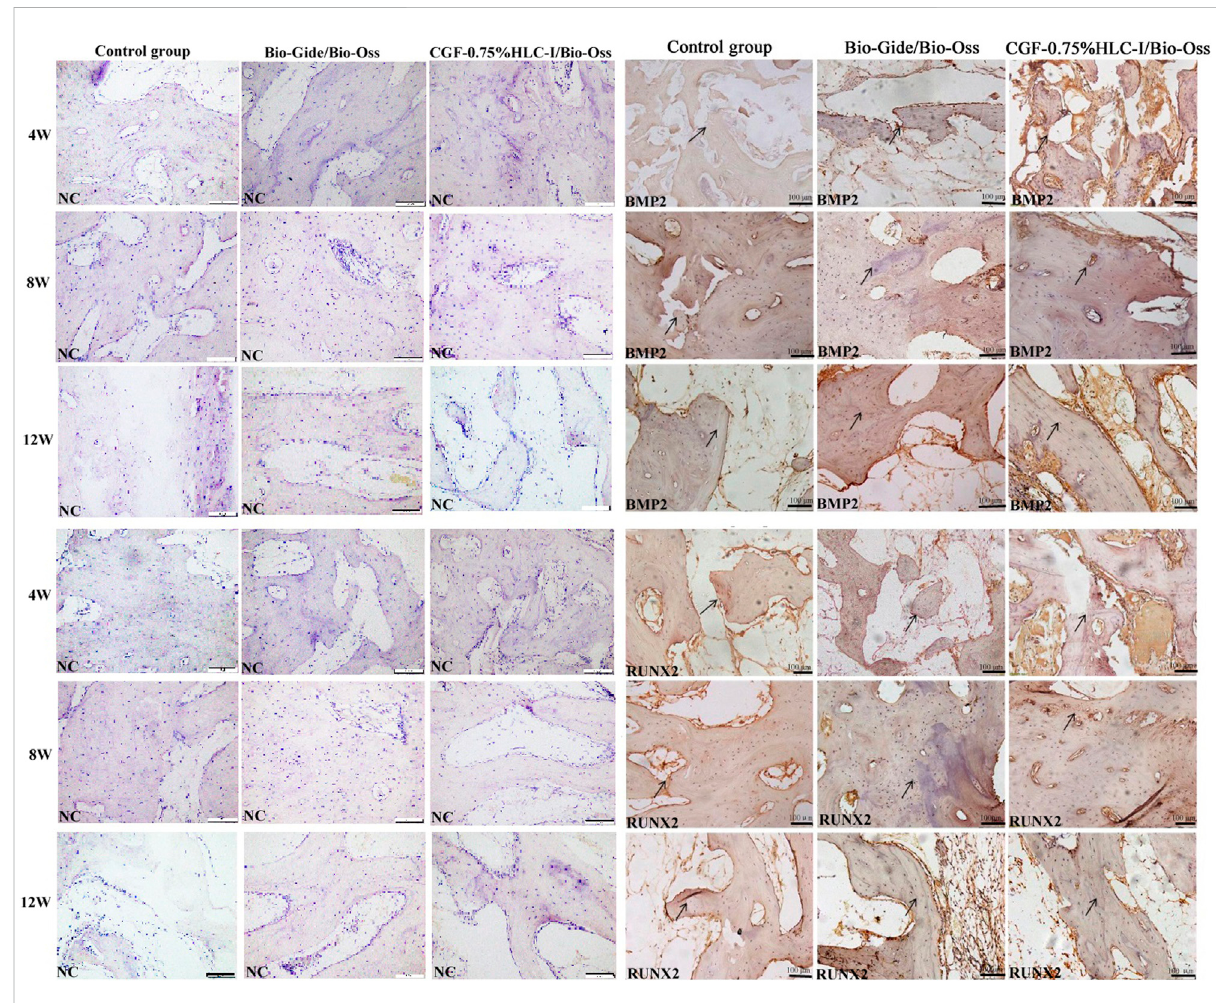
FIGURE 5 Immunohistochemical analysis of BMP-2 protein expression in control group, Bio-Gide/Bio-Oss group, CGF-0.75%HLC-I/Bio-Oss group (SP, ×200); Immunohistochemical analysis of RUNX-2 protein expression in control group, Bio-Gide/Bio-Oss group, CGF-0.75%HLC-I/Bio-Oss group (SP, ×200). NC- Negative Control.